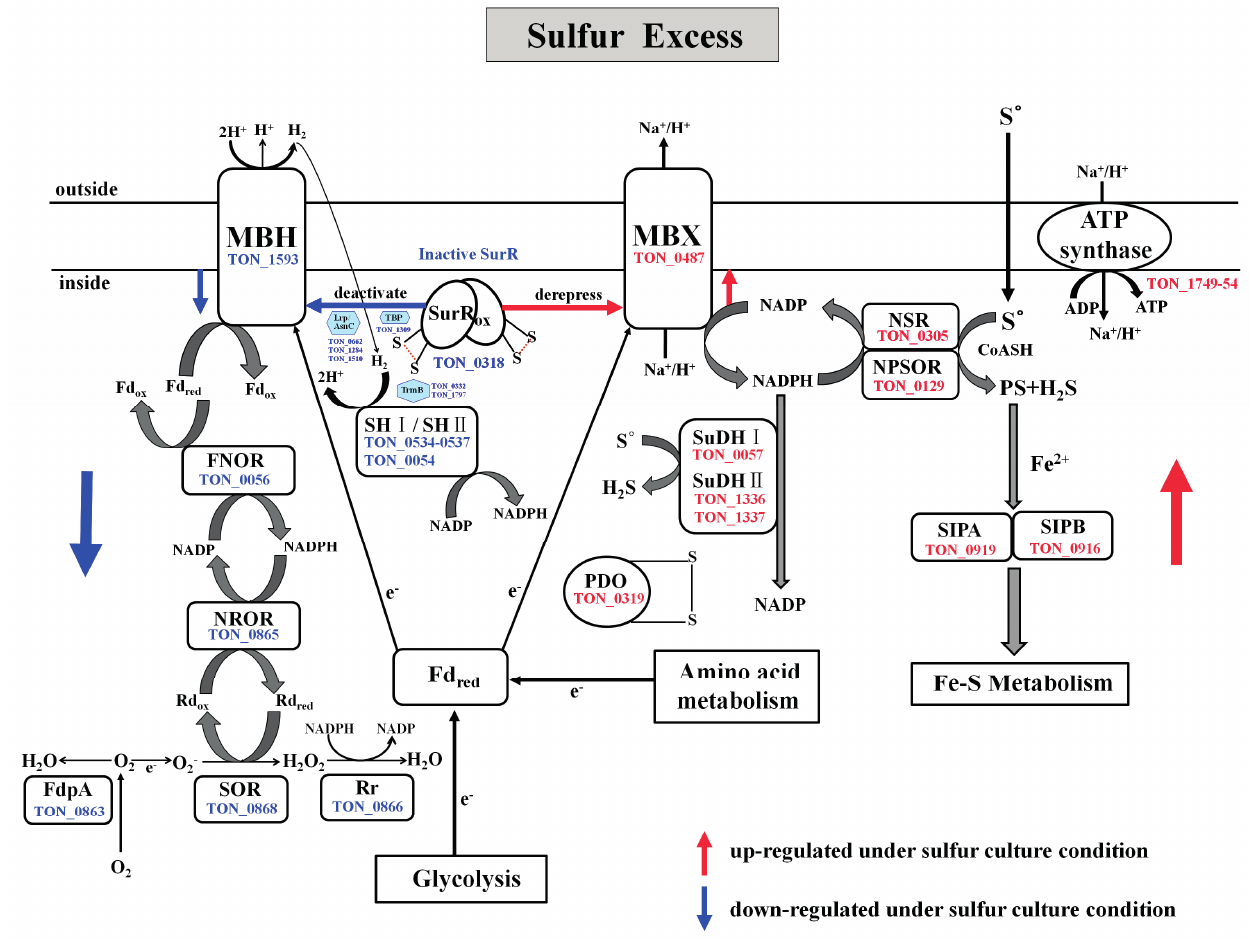
Figure 2. Pathways proposed for the reductive sulfur metabolism, H 2 -metabolism, and oxidative stress defense in T . onnurineus NA1. SurR is a redox-sensitive transcription regulator, which is down-regulated in the presence of S° via protein oxidation. When S° became available, oxidized SurR down-regulated the expression of the Mbh, TBP, TrmB, and Lrp/AsnC family of transcriptional regulators and the key enzymes involved in H 2 -metabolism, and oxygen detoxification, while concomitantly derepressing the expression of proteins related to S° reduction, such as MBX, as well as NSR, NPSOR and SuDH. All components depicted in the illustration were identified in comparative proteome analyses, and are represented by the name and gene identification numbers of T . onnurineus NA1. Down or up-regulated proteins (enzymes) during growth on sulfur are indicated with blue or red arrows,